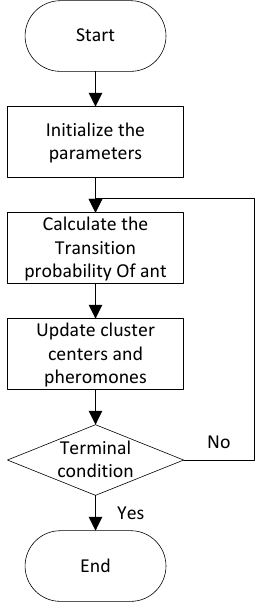
Figure 2. The flowchart of the ant colony clustering algorithm.